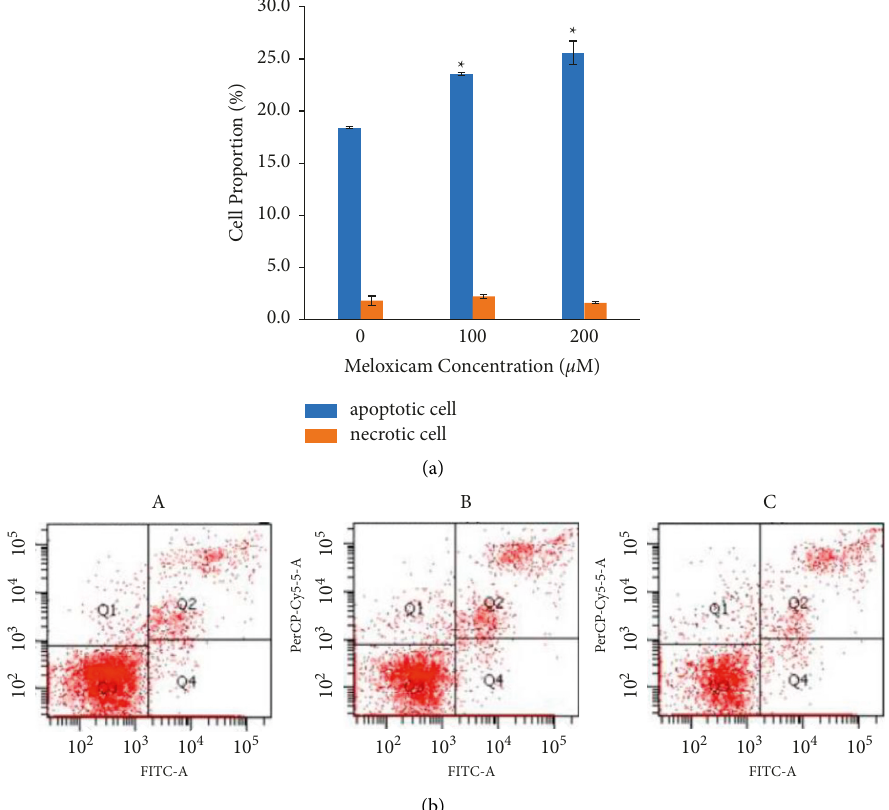
Figure 2: (a) The flow cytometry histogram of the percentage of Raji cells after 24 hours of incubation with various concentrations of meloxicam. ∗ p < 0 . 05 versus Raji cells untreated (control). (b) Representative dot plots of Raji cells treated with meloxicam (untreated (A); 100 μ M meloxicam (B); 200 μ M meloxicam (C)). The percentage of apoptotic cells increased significantly after being treated with meloxicam ( p < 0 .